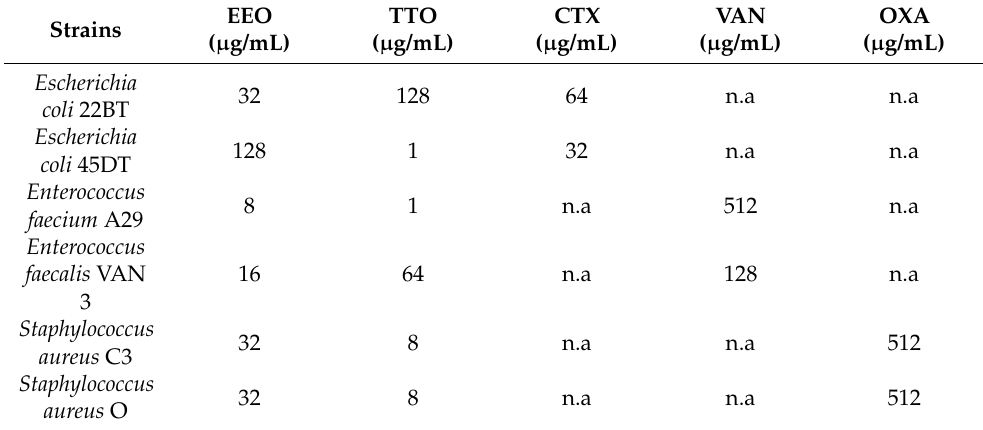
Table 3. Strains and respective MIC of EOs and antibiotics used in the study. EEO: eucalyptus, TTO: tea-tree, CTX: cefotaxime, VAN: vancomycin, OXA: oxacillin and n.a.: not